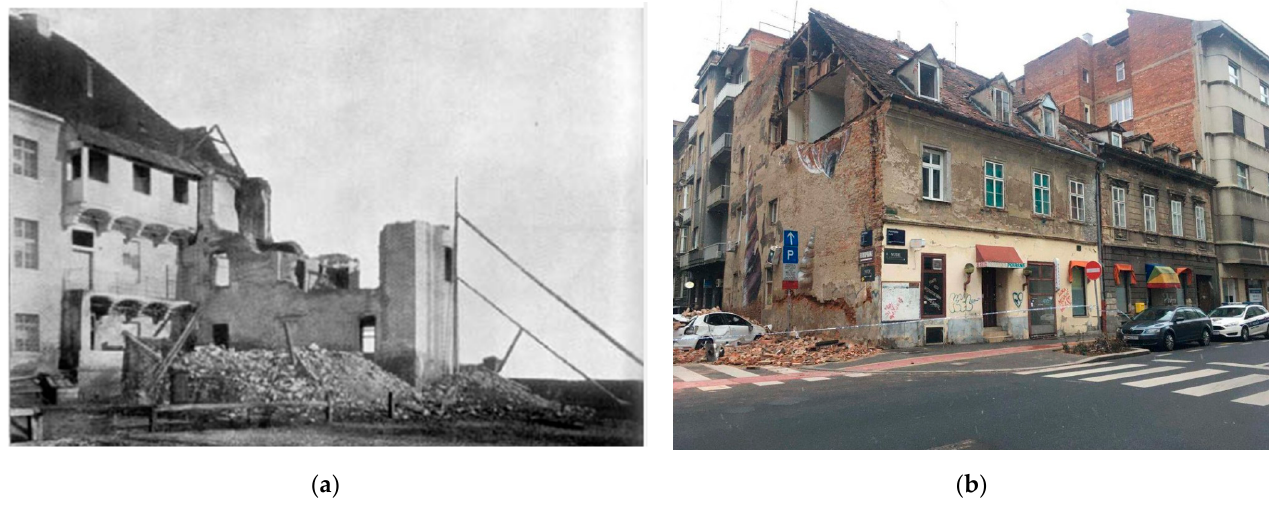
Figure 1. Building devastation after: ( a ) 1880 Zagreb earthquake [4] Reproduced with permission from Zagreb City Museum, 2022.; ( b ) 2020 Zagreb earthquake (author’s figures).